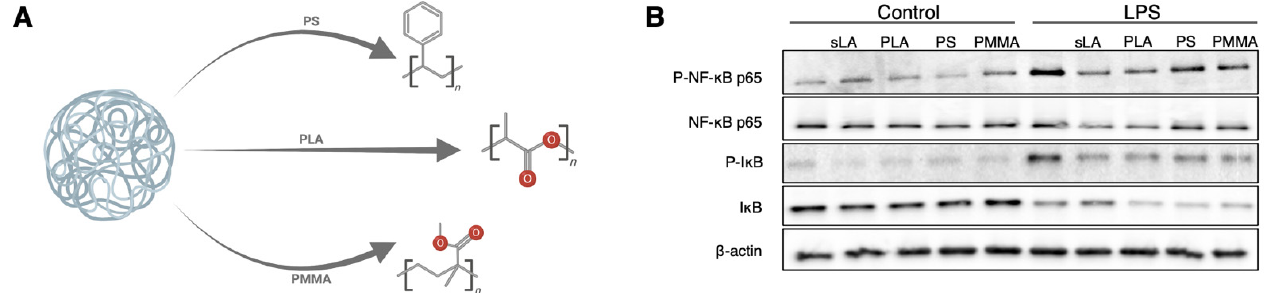
Figure 6. Suppression of NF- κ B p65 is dependent upon lactic acid polymer of the particles. ( A ) BMM Φ cells treated with soluble lactic acid (sLA), or nanoparticles composed of PLA-PEMA (PLA), polystyrene-COOH (PS), or poly(methyl methacrylate) (PMMA), for 3 h followed by 1 h LPS stimulation to show differential activation of p65 and greater baseline degradation of I κ B compared to sLA and LPS alone following particle incubation and 1h LPS stimulation. ( B ) Samples were immunoblotted for phospho-NF-kB p65 (Ser536), total NF-kB p65, phospho-I κ B (Ser32), total I κ B, and β -actin. Schematic in ( A ) created with BioRender.